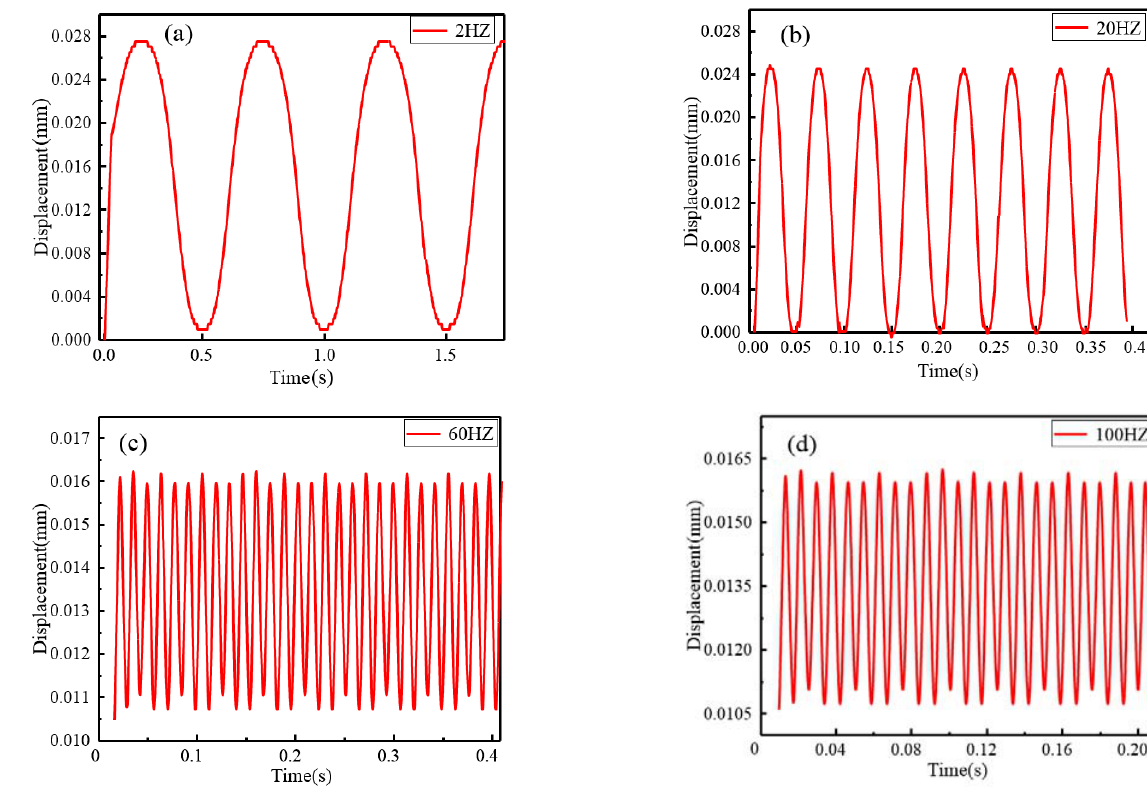
Figure 18. Displacement response: ( a ) 2 Hz, ( b ) 20 Hz, ( c ) 60 Hz, ( d )100 Hz.